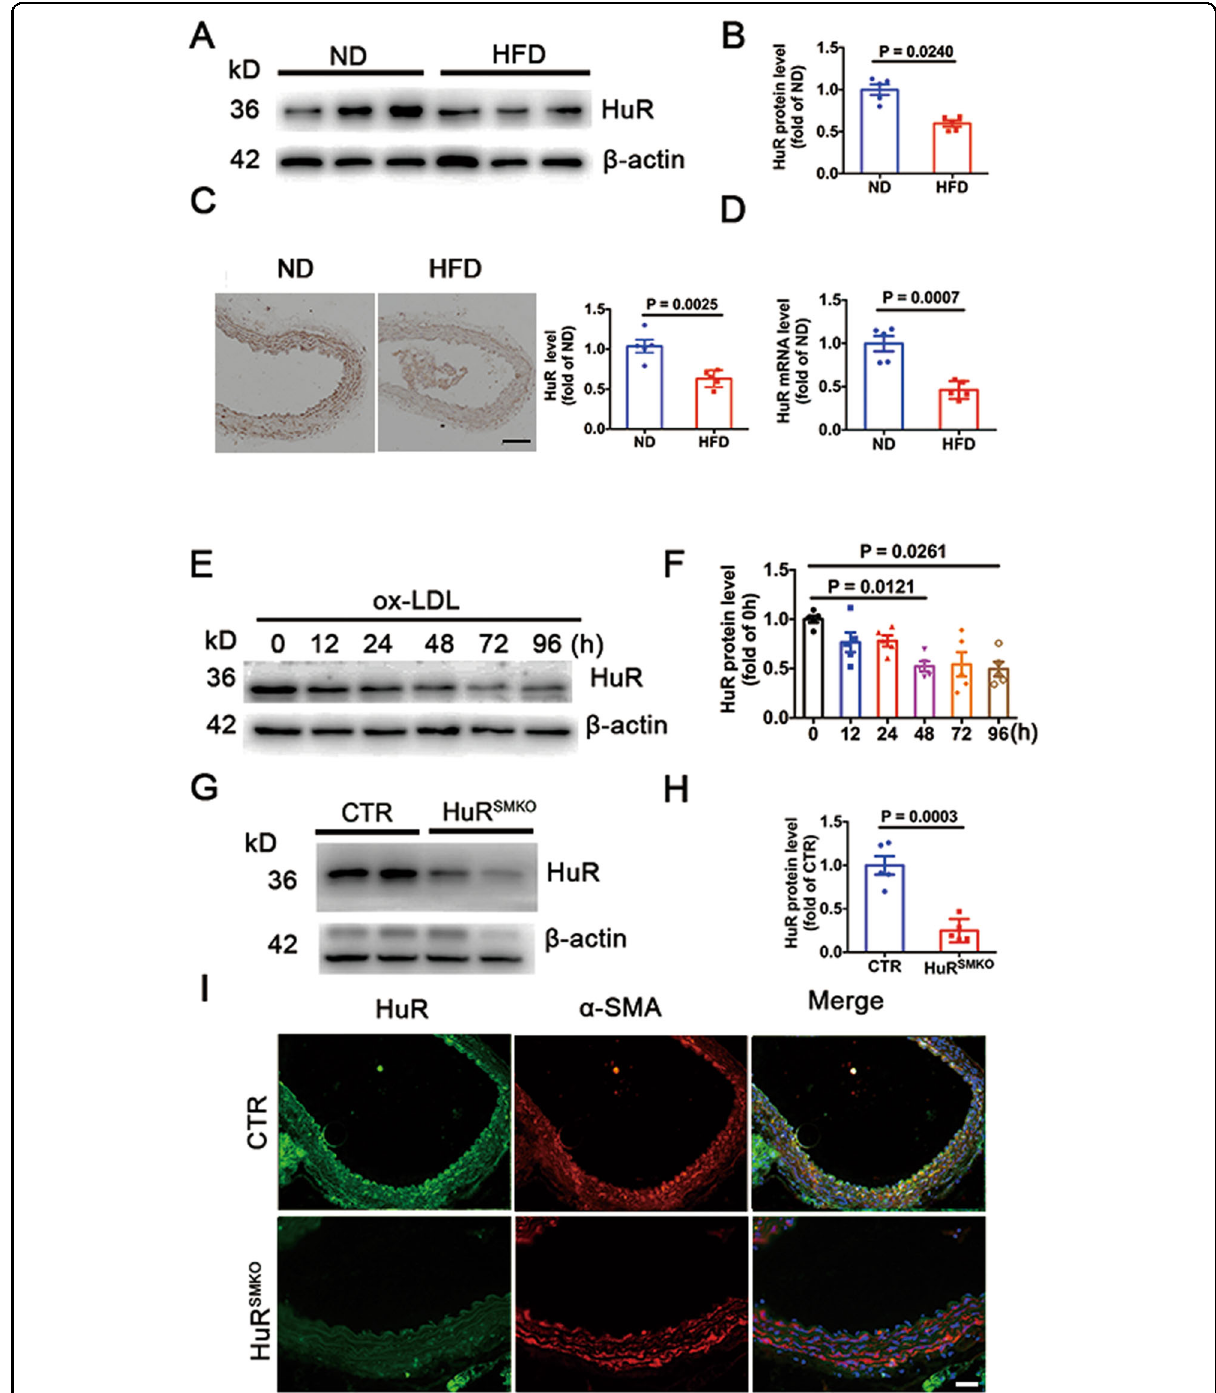
Fig. 1 HuR levels were reduced in atherosclerotic plaque. A , B Western blot analysis of HuR protein level in aortas from apolipoprotein E- knockout (ApoE − / − ) mice fed a high-fat diet (HFD) or normal diet (ND) ( n = 5). C Immunohistochemical staining of HuR in aortas from ApoE − / − mice fed an HFD or ND ( n = 5). D Quantitative RT-PCR analysis of HuR mRNA level in aortas from ApoE − / − mice fed an HFD or ND ( n = 5). E , F Western blot analysis of HuR protein level in vascular smooth muscle cells (VSMCs) induced by 50 μ g/ml oxidized low-density lipoprotein (ox-LDL) at different times ( n = 5). G , H Western blot analysis of HuR protein level in aortas from control and HuR SMKO mice ( n = 5). I Immuno fl uorescent staining of aortas from control and HuR SMKO mice to determine HuR (green) and α -SMA ( α -smooth muscle actin; red) localization. Scale bar = 50 μ